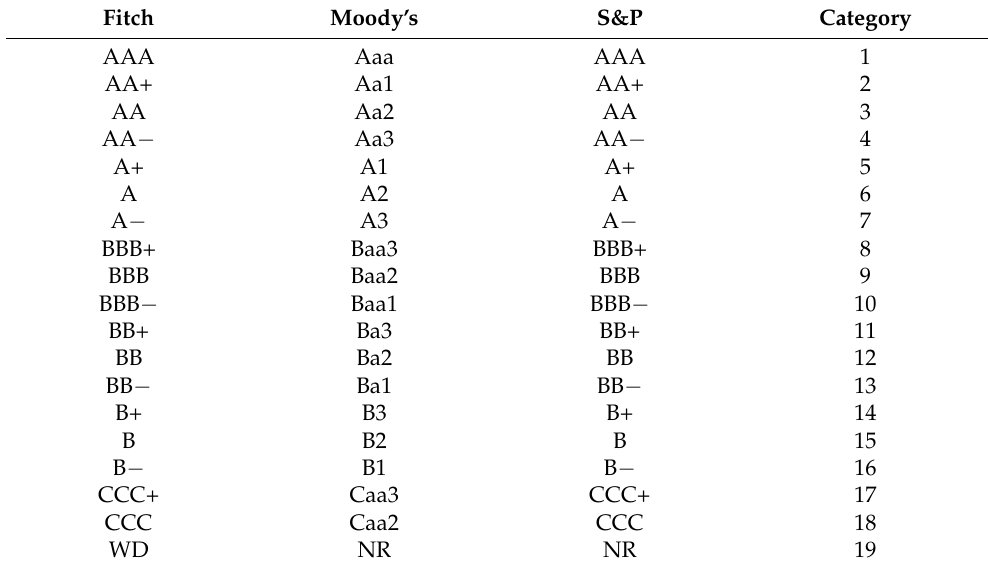
Table A1. Transformation of rating